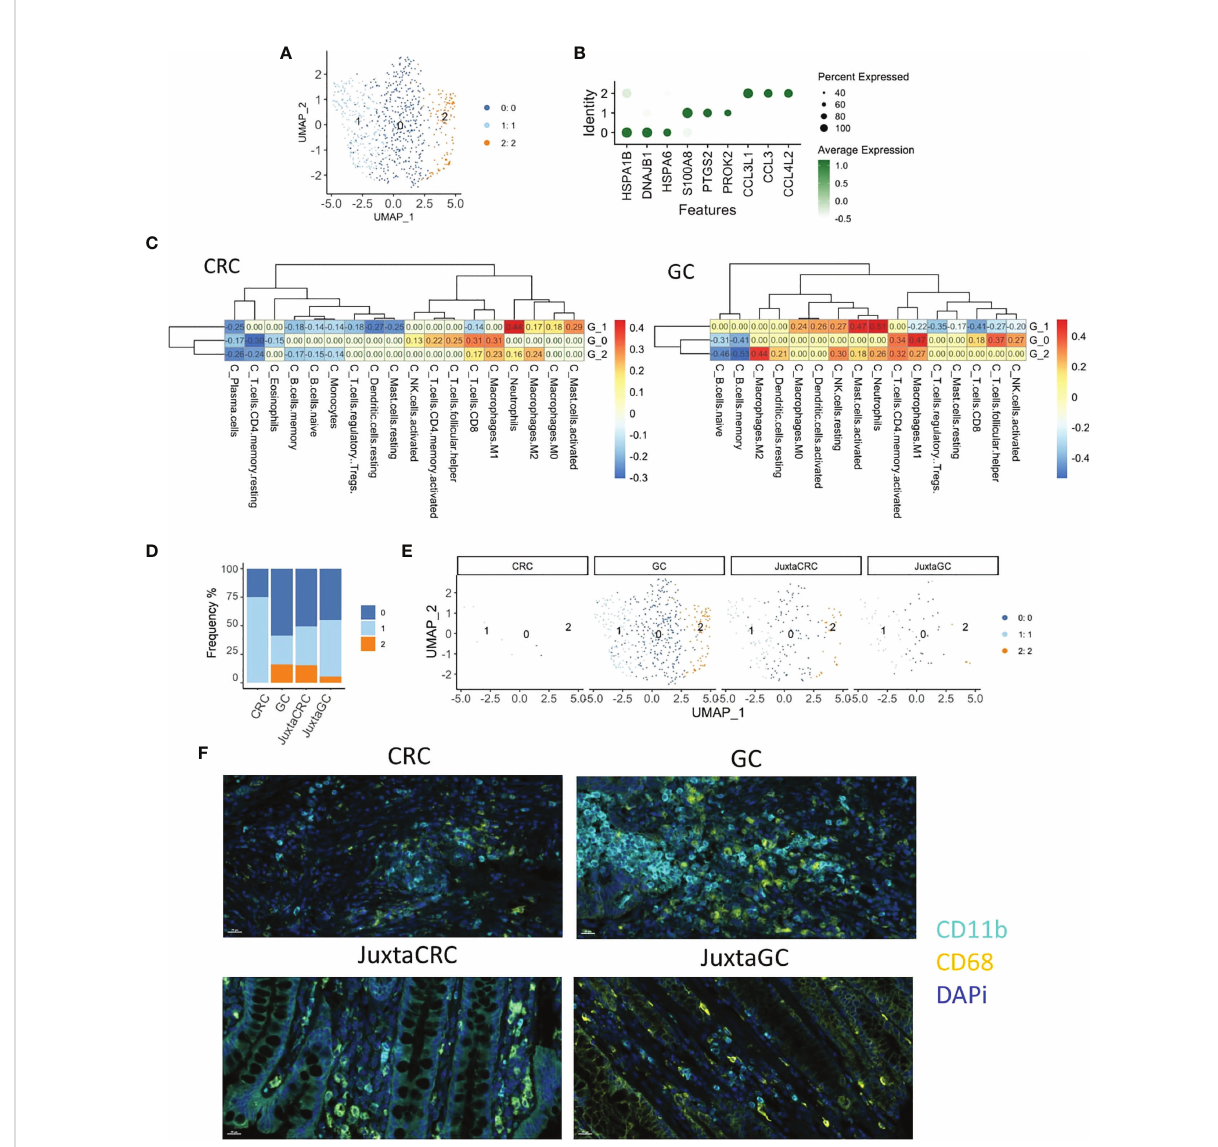
FIGURE 3 Myeloid cell enrichment in the GC site. (A) UMAP plots of the myeloid cell population reveal three cell subsets, namely, clusters 0, 1, and 2. (B) Dot plot shows the top three cluster-speci fi c feature genes, dot size indicates the percent expressed, and the level of color indicates the average expression. (C) Heatmaps show the correlation relationship between subset GSVA score and the fraction of 22 subpopulations of immune cells of CRC and GC, respectively, generated by CIBERSORT (left: CRC, right: GC). (D) Bar plot displays the population of each myeloid cell subset across samples. (E) UMAP plots of the myeloid cell population spat by samples. (F) mIHC staining of CD11b (cyan), CD68 (yellow), and DAPi (blue) in CRC, GC, JuxtaCRC, and JuxtaGC